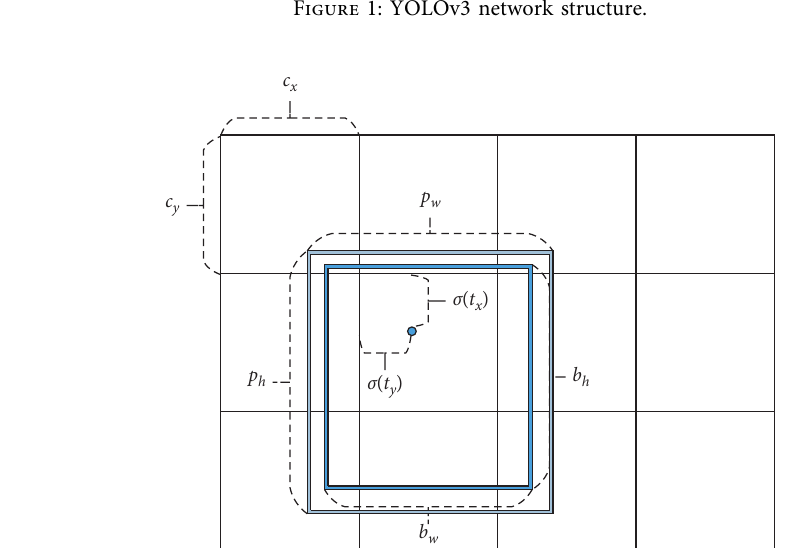
Figure 2: Border